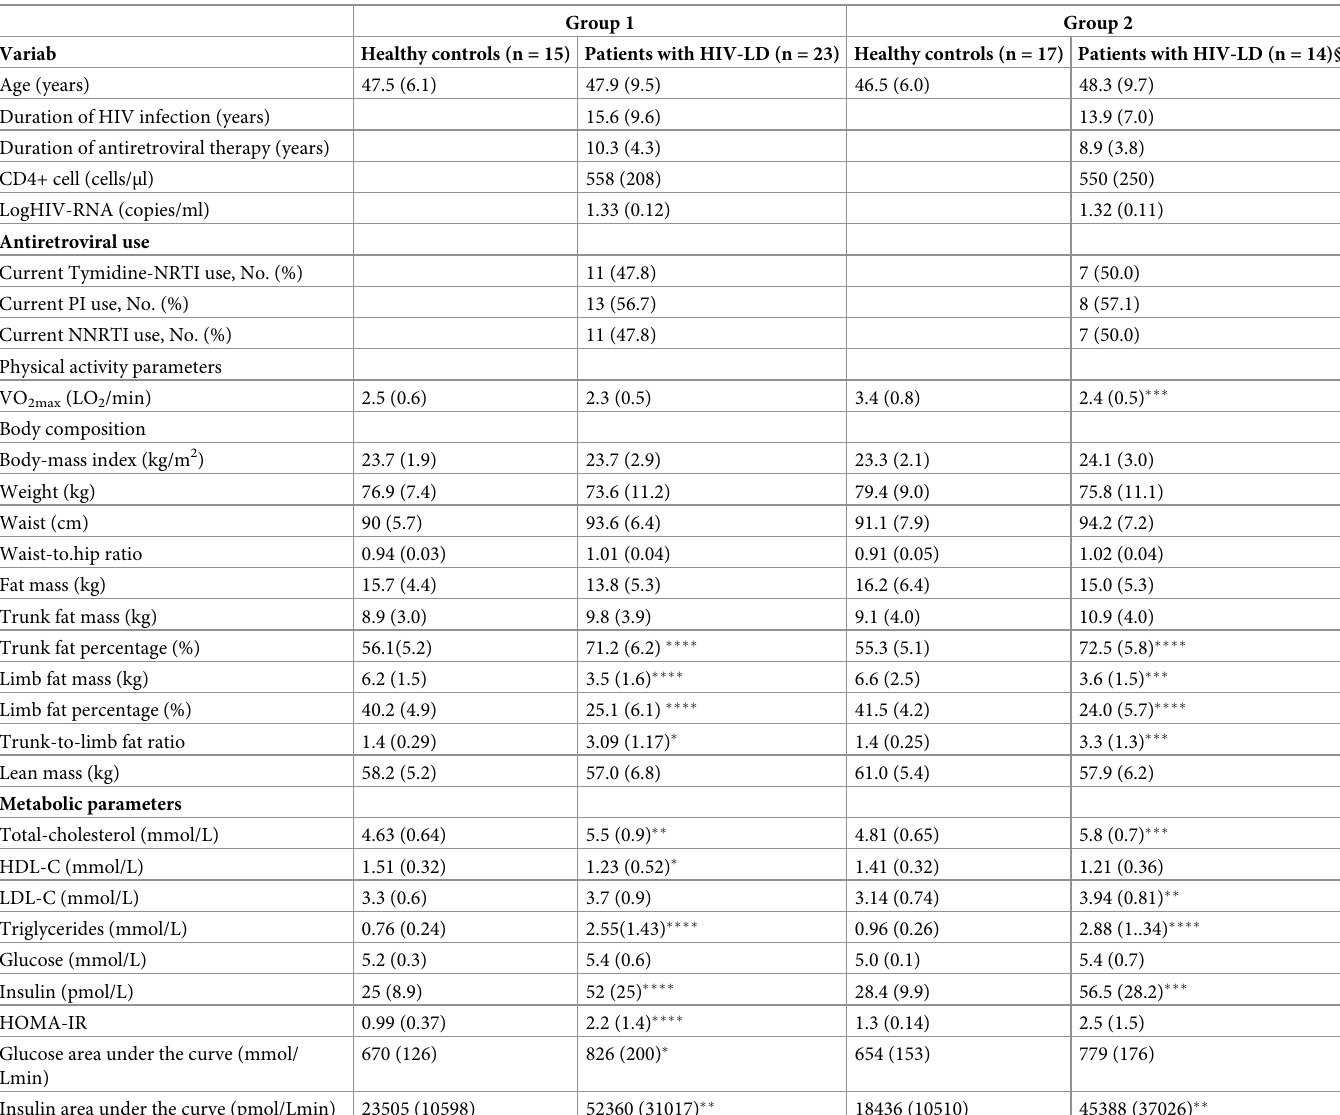
Table 1. Baseline characteristics of patients and healthy